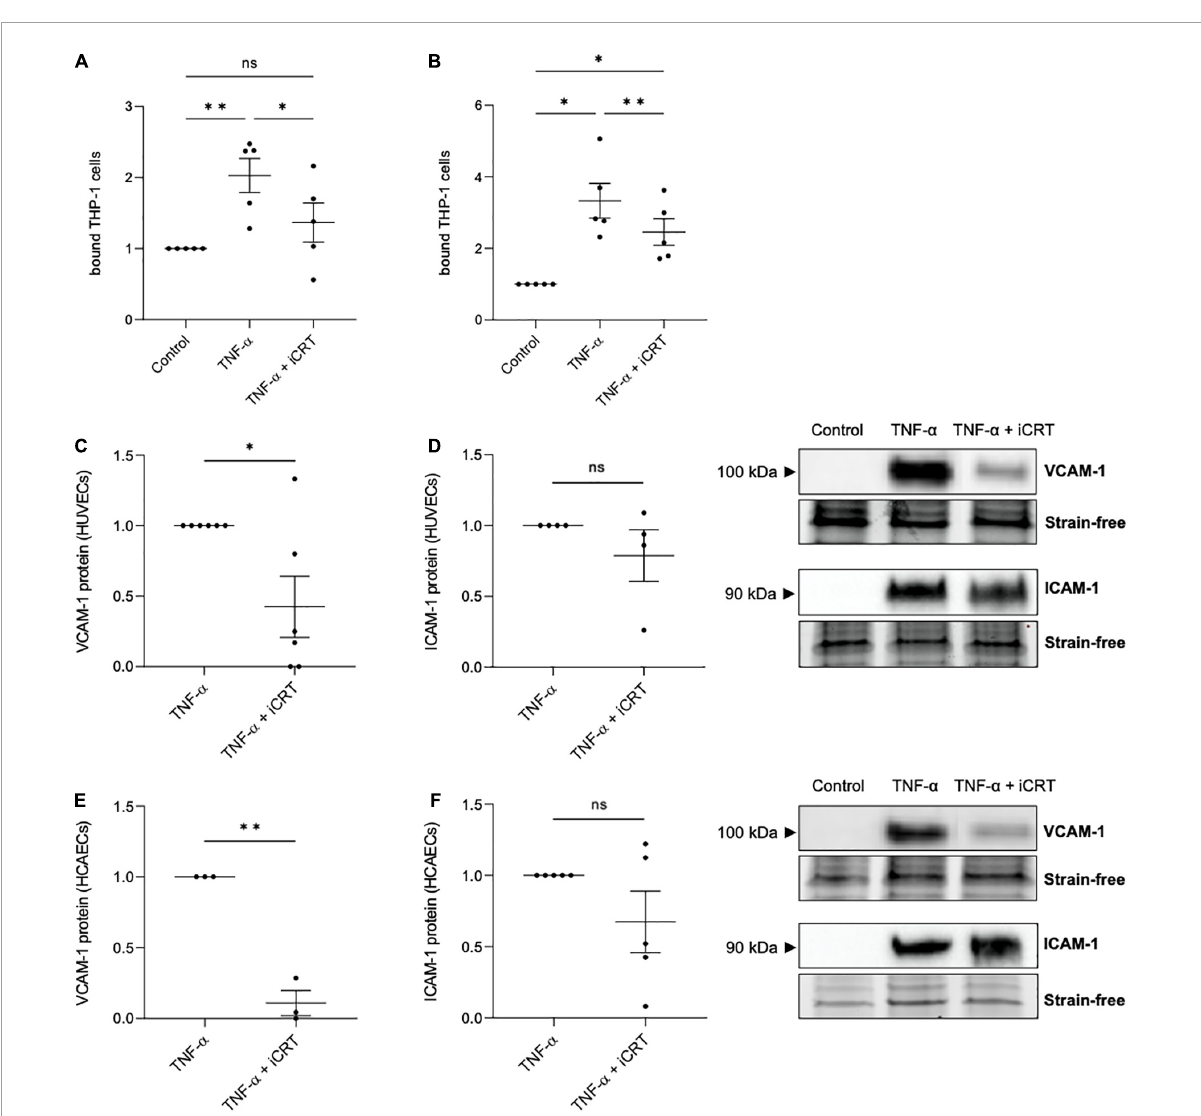
FIGURE3 Inhibition of Wnt/ β -catenin signaling reduced TNF- α -induced monocyte-adhesion. Cultured endothelial cells were stimulated with 10 ng/mL recombinant human tumor necrosis factor- α (TNF- α ) and supplemented with either 0.05% DMSO vehicle control or 25 µ M inhibitor of β -catenin-responsive transcription (iCRT) for 18 h. Calcein-labeled THP-1 cells were allowed to adhere to human umbilical vein endothelial cells (HUVECs) (A) or HCAECs (B) for 30 min, then adherent cells were quantified and expressed as a fold change of control ( n = 5 each). In HUVECs, VCAM-1 (C) , and ICAM-1 (D) from whole cell lysates were quantified by Western blotting, normalized to stain-free loading controls and expressed as a fold change of TNF- α ( n = 6 and 4, respectively). Representative Western blots shown. In HCAECs, VCAM-1 (E) , and ICAM-1 (F) from whole cell lysates were quantified by Western blotting, normalized to stain-free loading controls and expressed as a fold change of TNF- α ( n = 3 and 5, respectively). Representative Western blots and stain-free loading controls are shown. ∗ Indicates p < 0.05, ∗∗ p < 0.01, ∗∗∗ p < 0.001, and ∗∗∗∗ p < 0.0001. NS denotes not